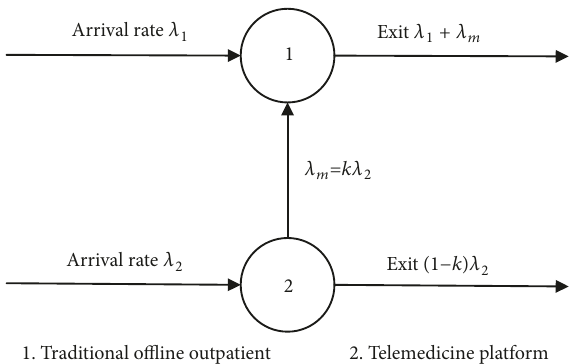
Figure 1: The dual-channel healthcare